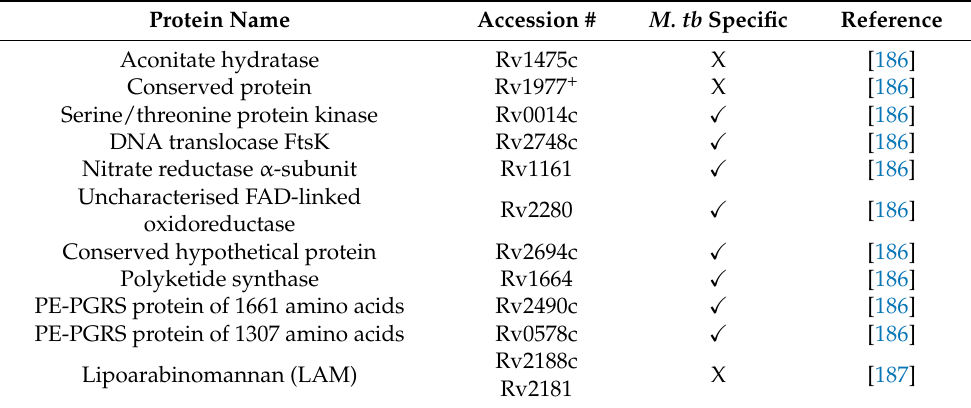
Table 5. M. tb proteins identified in human urine samples from active TB